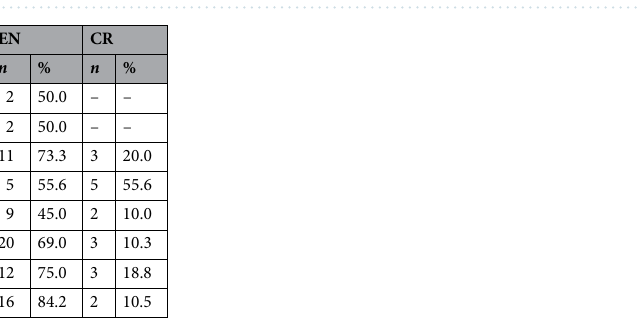
Table 2. Number and percentage of species changing from Not Evaluated to a threat category, Vulnerable (VU), Endangered (EN) and Critically Endangered (CR), in all major uses and in at least one climate change